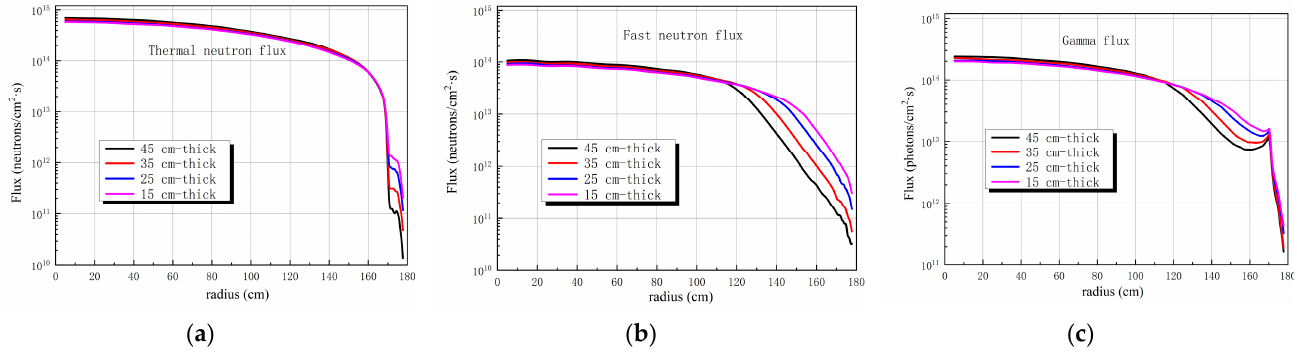
Figure 4. Radial fluxes in scheme B (with B 4 C barrel) with different thicknesses of reflector: ( a ) thermal neutron flux distribution; ( b ) fast neutron flux distribution; ( c ) gamma flux distribution.